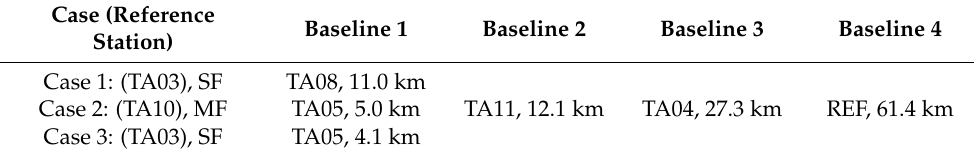
Table 3. Baselines used for single-baseline post-processed kinematic (PPK)